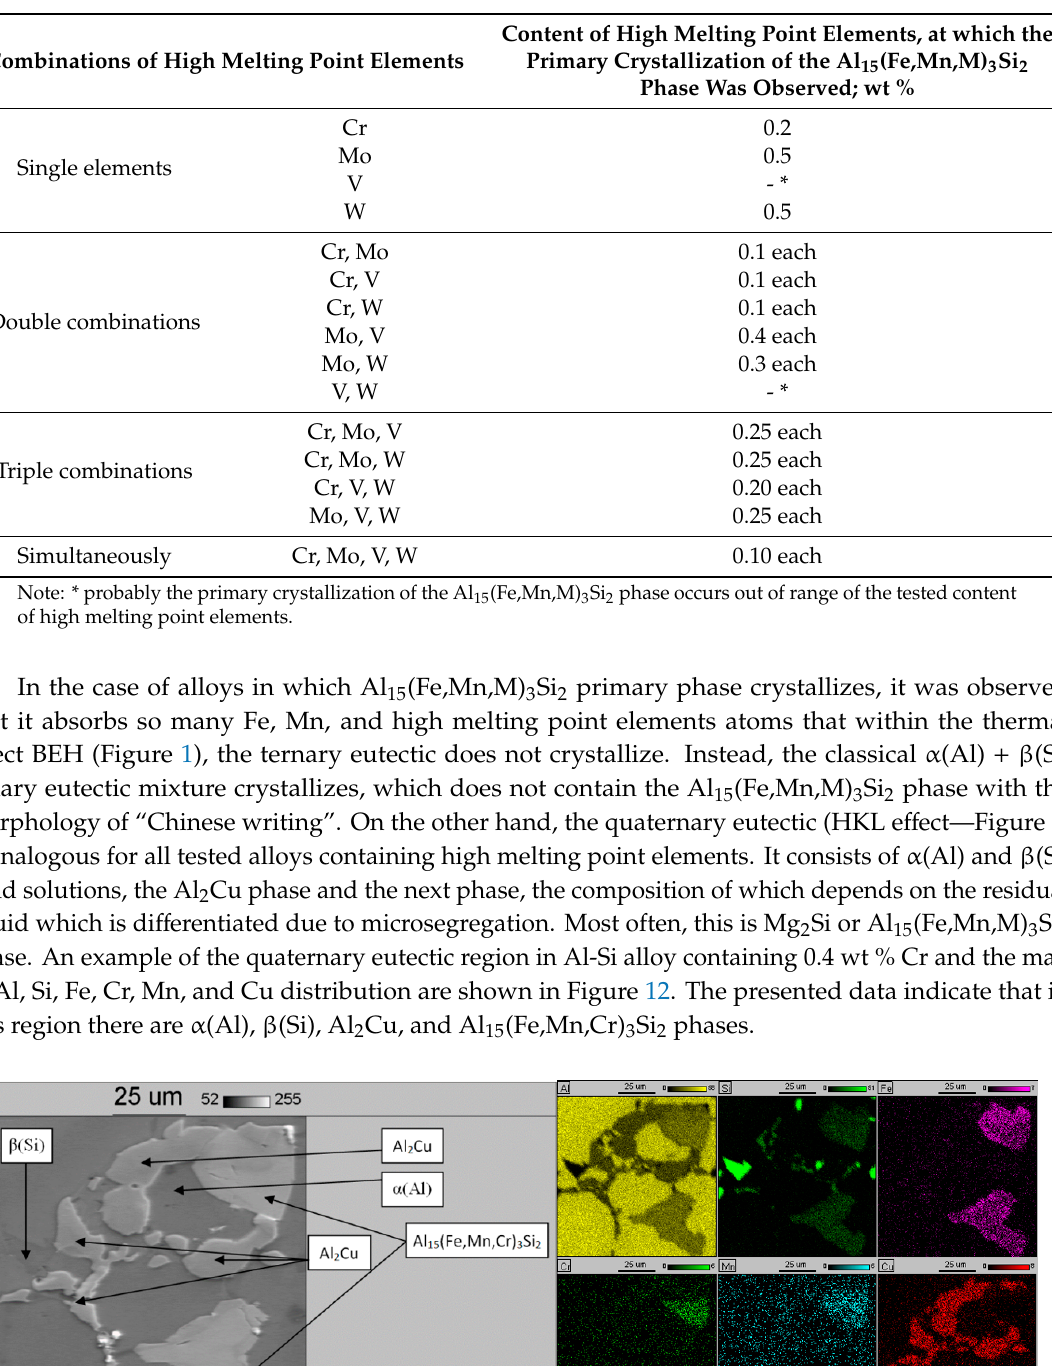
Table 3. Minimum content of high melting point elements, at which the primary intermetallic Al 15 (Fe,Mn,M) 3 Si 2 phases were observed.